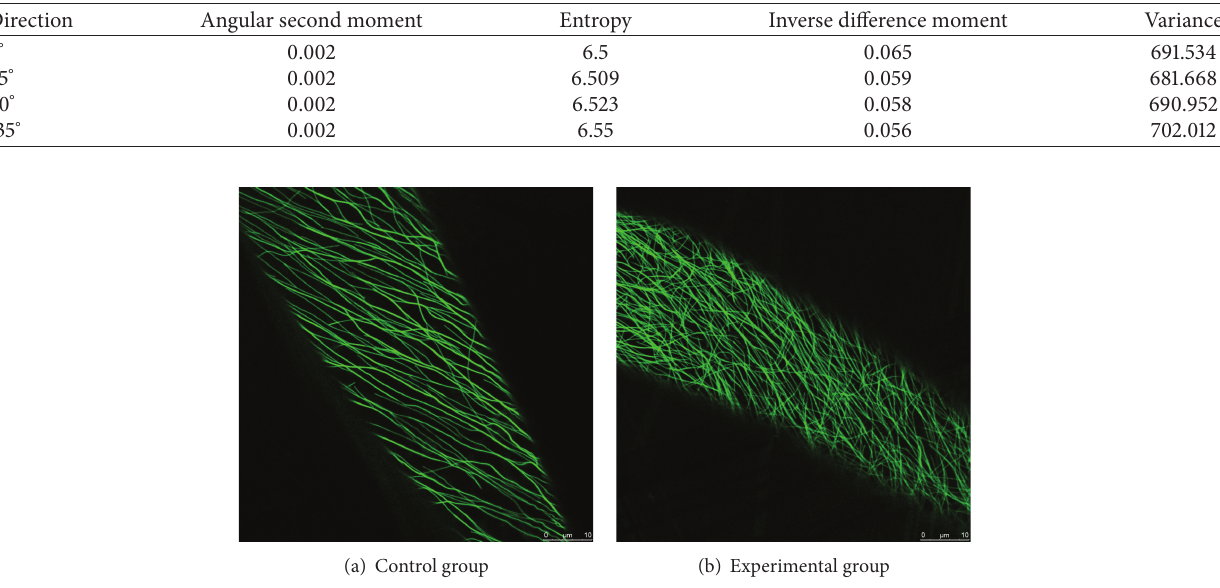
Table 1: The texture features extraction based on GLCM algorithm.